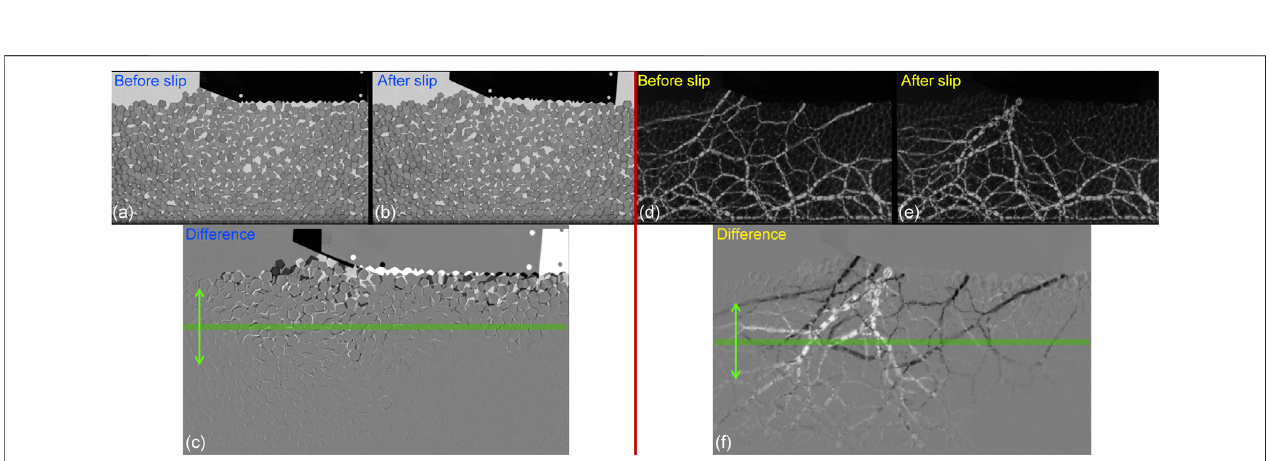
FIGURE 12 | (A – C) White light images (A) before and (B) after a slip event are subtracted to estimate the depth of grain motion across many slip events. (C) The difference image between (A,B) (D – F) Polarizedlightimages (A) before and (B) after a slipevent aresubtractedto estimate the depth ofin fl uence offorcechains across many slip events. (C) The difference image between (A,B) . Before averages are computed across slip events, the absolute value of the before-after difference image must be taken. The green arrows and boxes demonstrate the measurement of intensity change with depth that is performed on (C) 〈 | Δ I W | 〉 and (D) 〈 | Δ I P | 〉 to produce the data in Figure 13